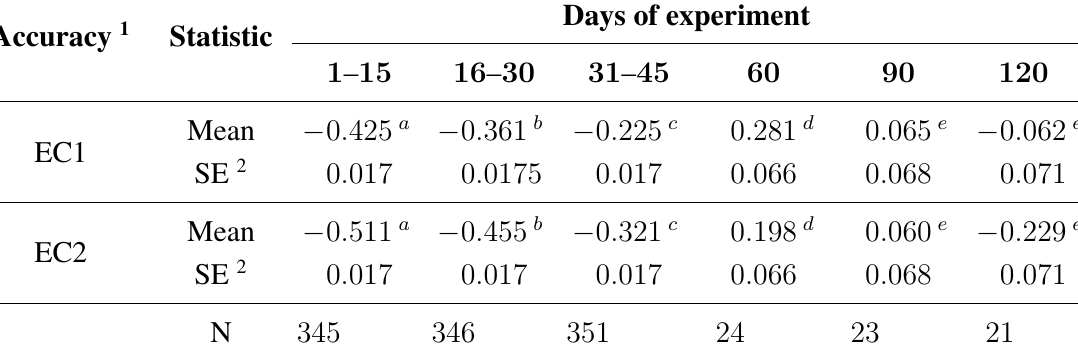
Table 8. Results of ANOVA analysis of C1 conductimeter accuracy (mS/cm) among time of on-line milking parlour